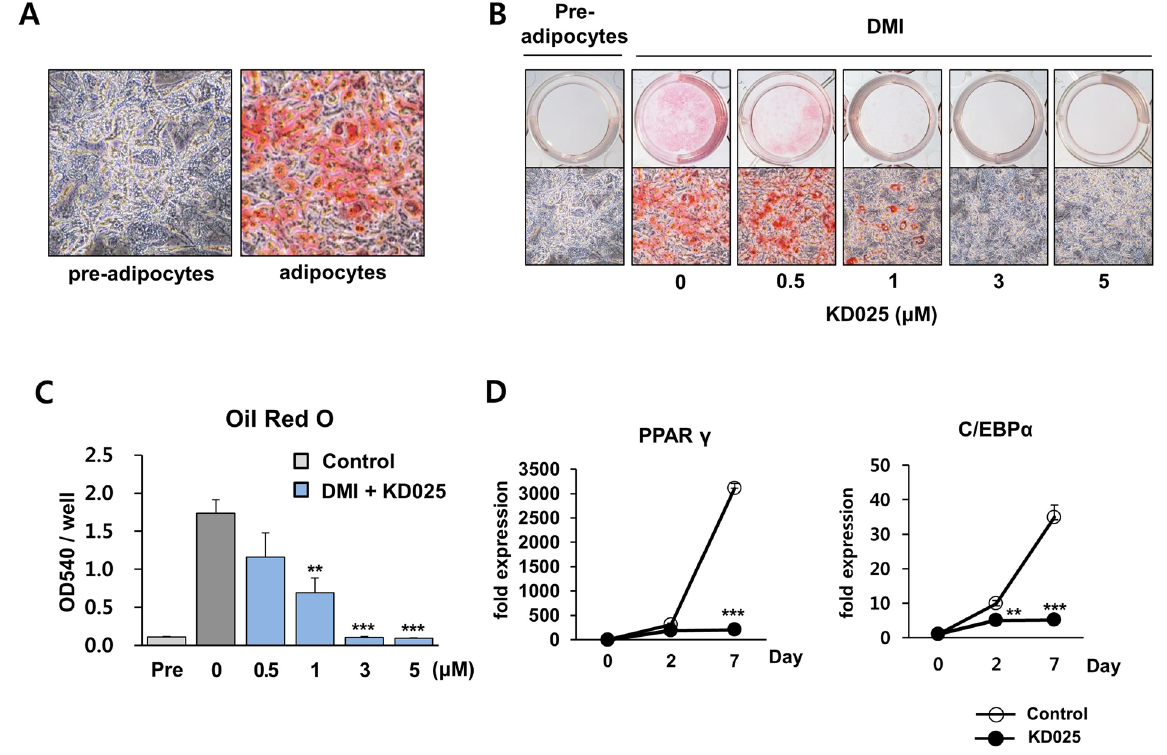
Figure 1. Effect of KD025 on adipogenesis in 3T3-L1 adipocytes. 3T3-L1 cells were differentiated through incubation in DMI (dexamethasone, IBMX, and insulin mixture) with or without KD025. ( A – C ) Pre- adipocytes and differentiated adipocytes were stained with Oil Red O at day 8 after the start of differentiation (day 0). ( B ) Concentrations of 0, 0.5, 1, 3, and 5 µ M of KD025 with DMI were used to treat cells. Macroscopic and microscopic pictures of cells are shown. ( C ) Lipid accumulation was assessed by measuring absorbance at 540 nm of Oil Red O. ** p < 0.01; *** p < 0.001 vs . untreated. ( D ) Cells were differentiated with or without 5 µ M of KD025 and mRNA expression of Pparg and Cebpa was measured by real time PCR at days 0, 2, and 7. The data are the representative from more than three independent experiments. Data are expressed as means ± S.E. based on triplicate. ** p < 0.01; *** p < 0.001 vs . the corresponding control